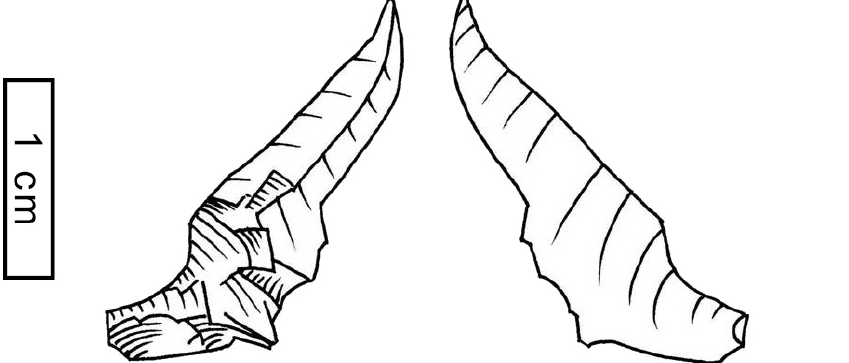
Figure 21. Flake 5.19 d2 illustrating direction of removal blow in relation to axis of the dorsal ridge of the blade (drawing by the